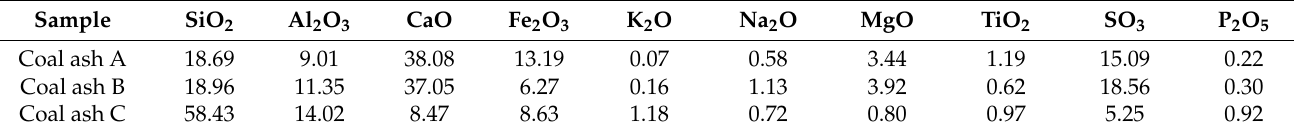
Table 2. The ash compositions (wt %) of raw